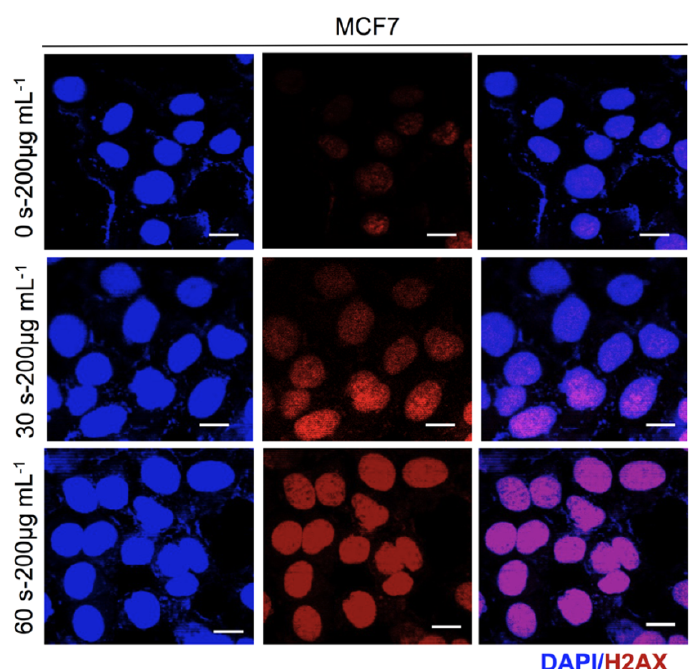
Figure 9. Plasma-treated mushroom-derived extracts provoke DNA damage in breast cancer cells. Quantification of H2AX foci formation in MCF7 cells by immunofluorescence staining treated as indicated. Scale bar, 20 µm.